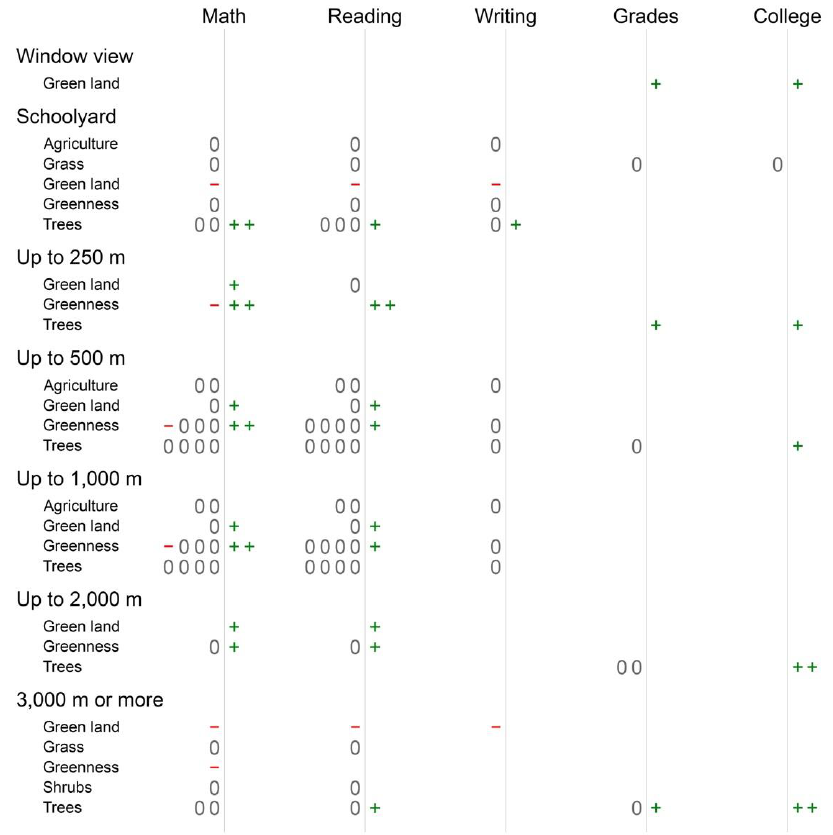
Figure 2. Counts of findings by outcome and green space measure with symbols representing the following associations between academic performance and green space: + = statistically significant positive association, 0 = non-statistically significant association, and - = statistically significant negative association. Metric distances (e.g., “Up to 250 m”) represent the radius of circular buffers or diameter of polygons centered on a school. Statistical significance requires p < .05 for 50% or more of analyses summarized in articles that included a measure or proxy for socioeconomic status (i.e., the percentage of students eligible free-or-reduced lunch) because SES often predicts green space cover and vice-versa [57,70,71]. As such, bivariate correlation coefficients were not included in this summary.